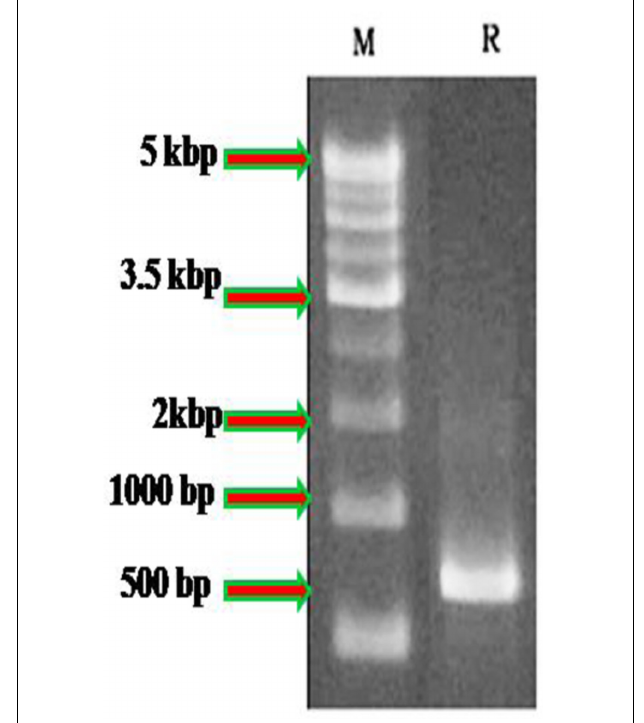
FIGURE 1 | Molecular analysis of Penicillium daleae using ITS1-5.8S–ITS2 rRNA gene compared with 500 bp marker. M, ladder; R, P. daleae .